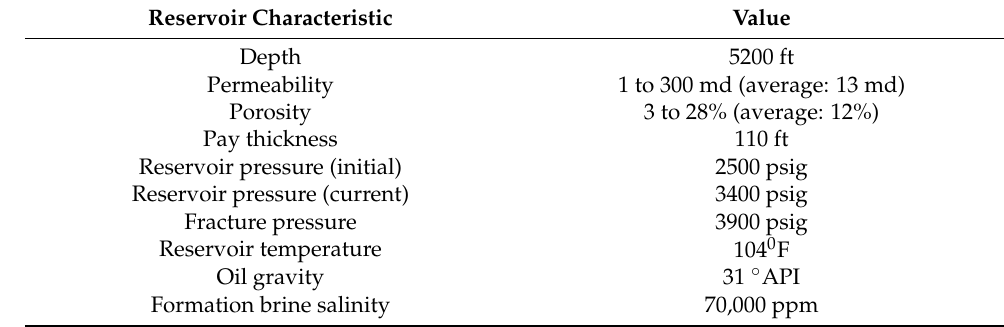
Table 1. Reservoir and fluid properties of the San Andres unit in the East Seminole